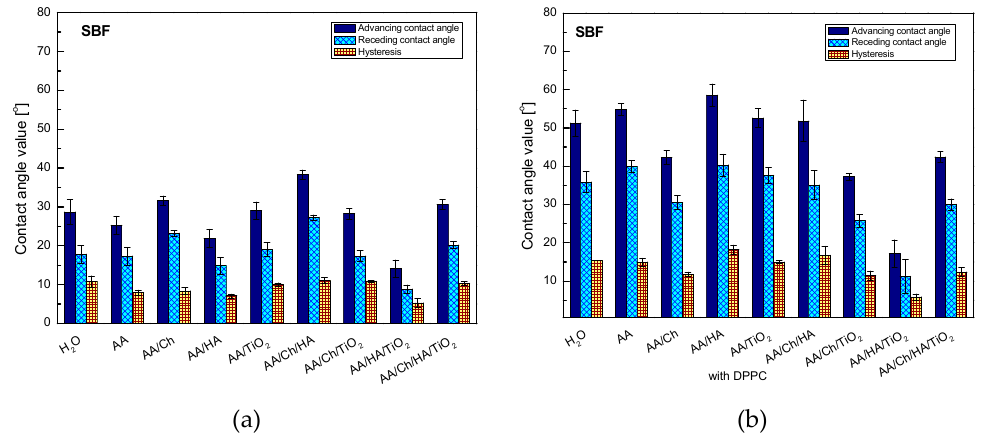
Figure 4. Advancing and receding contact angles of simulated body fluid (SBF) and its hysteresis on the activated glass plates after the contact with the subphase in the absence of DPPC ( a ) and in the presence of DPPC ( b ).